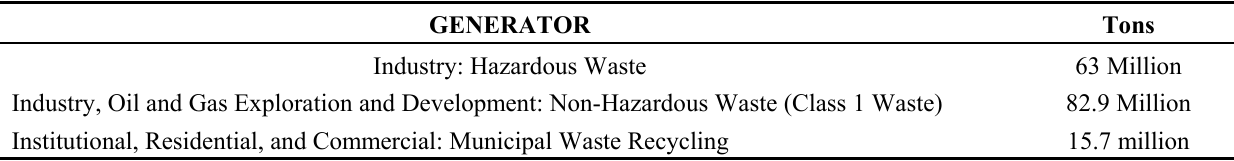
Table 6. Generators of Hazardous Waste in Texas.